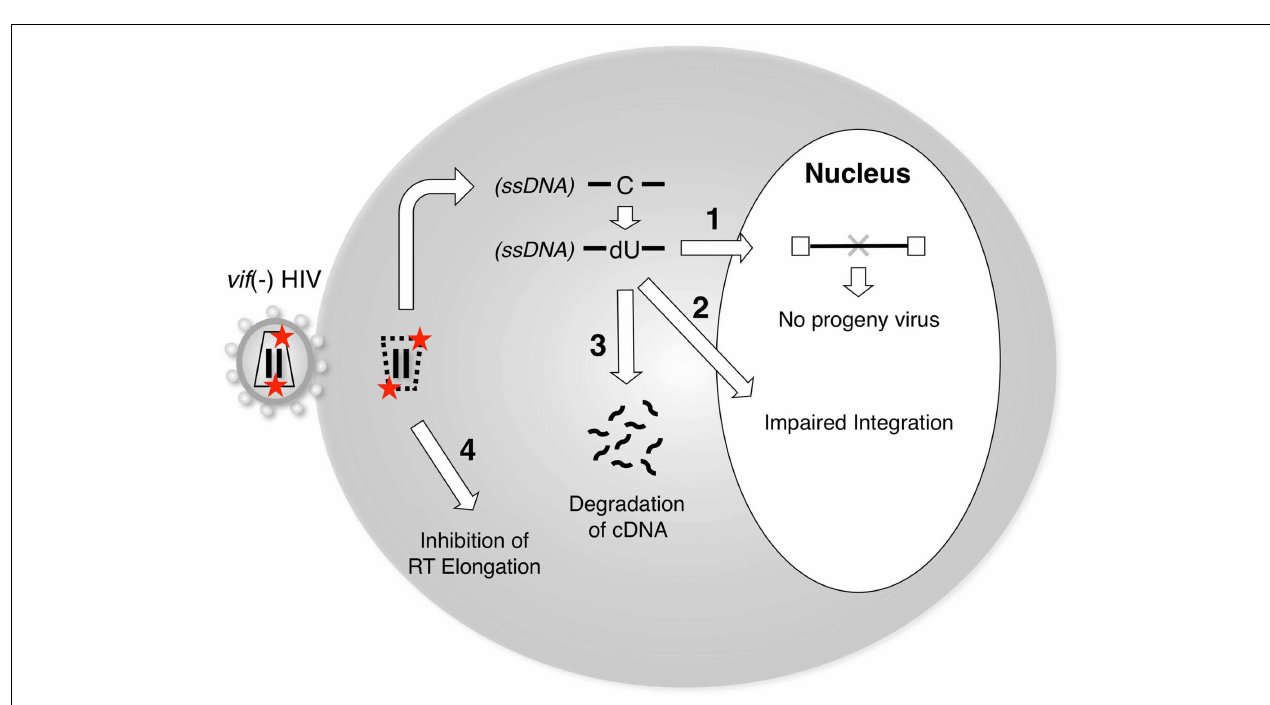
A3G-mediated editing might create aberrant structures at viral DNA ends, which might be inefficient substrates for integration. (3)The reverse transcripts containing dU might induce DNA degradation by cellular DNA repair pathways. (4) RT-mediated elongation could be blocked by the presence of A3G on RNA or DNA templates. A3G might exert both deaminase activity-dependent (1–3) and deaminase activity-independent (4) functions to inhibit vif -deficient HIV-1